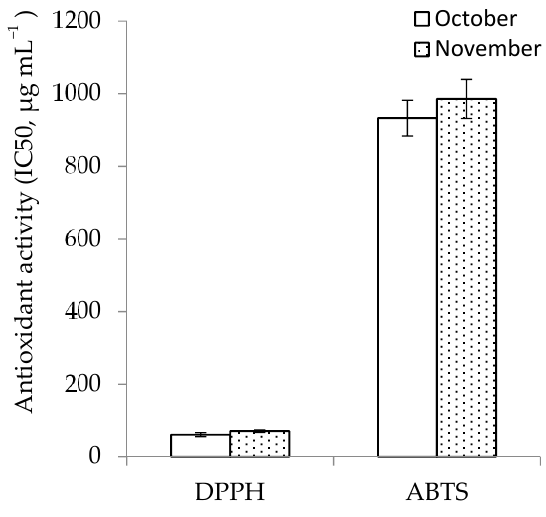
Figure 3. Antioxidant activity of A. japonica roots. Table 2. Pearson correlation coefficients between the phenolic compounds and antioxidant activity of A. japonica roots